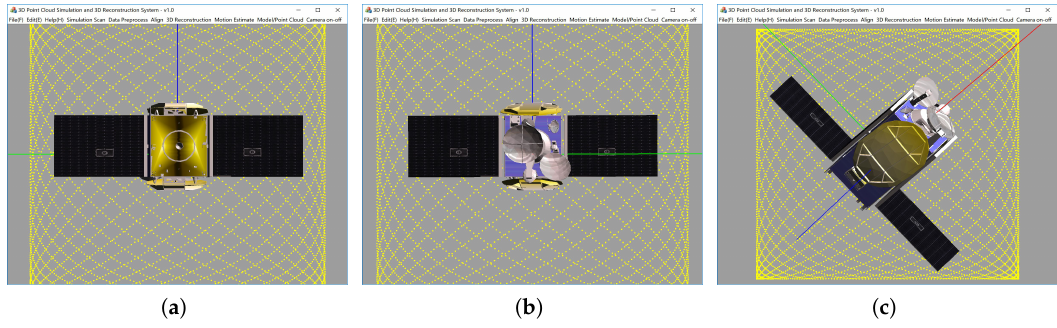
Figure 10. Three different initial attitudes of numerical simulated experiments. ( a ) α = 0 ◦ , β = 0 ◦ , γ = 0 ◦ ; ( b ) α = 0 ◦ , β = 180 ◦ , γ = 0 ◦ ; ( c ) α = − 120 ◦ , β = 0 ◦ , γ = 40 ◦ .